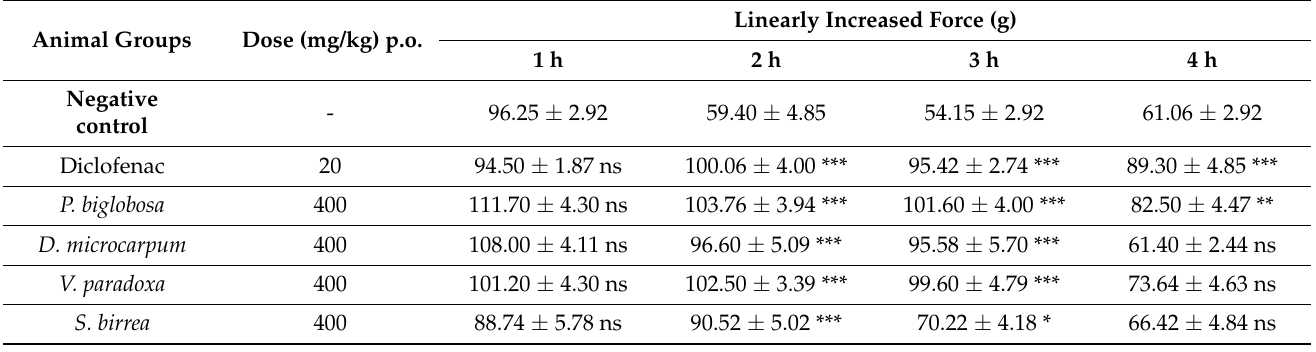
Table 3. Nociceptive threshold after oral administration of tested extracts (Randall–Selitto test). Animal Groups Dose (mg/kg)